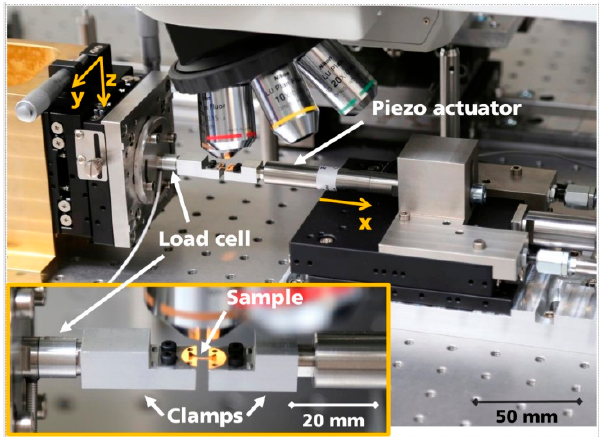
Figure 2. Images of the custom-built micromechanical testing device used in the presented work.